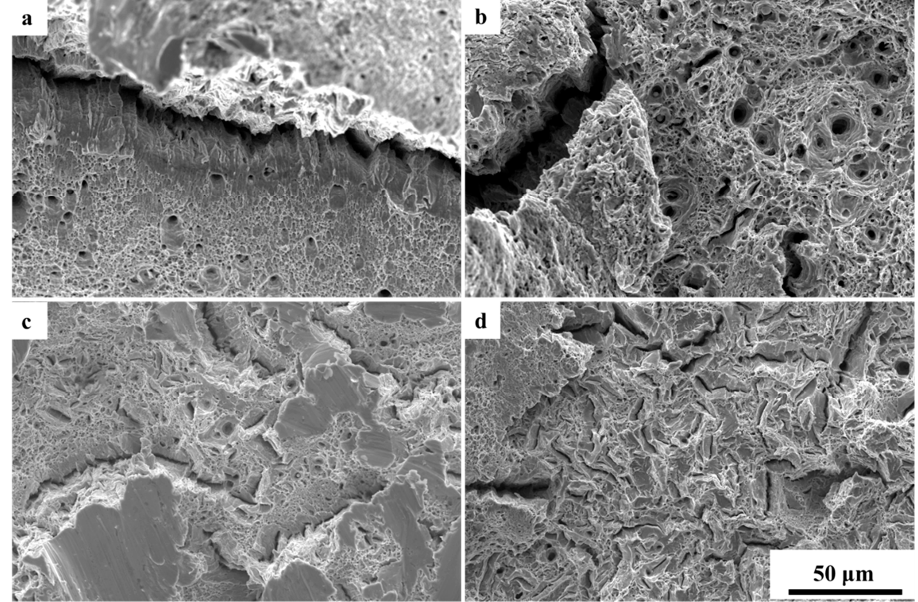
Figure 6. SEM images showing the microscopic fractographs of samples tested at different temperatures: ( a ) − 80 °C, ( b ) − 120 °C, ( c ) − 160 °C, and ( d ) − 196 °C, corresponding to the marked area in Figure 5.